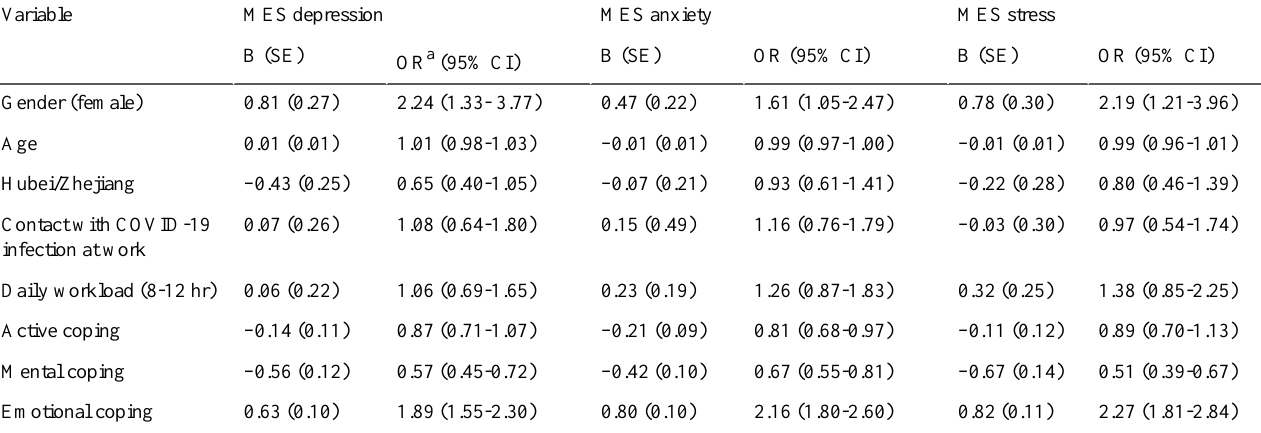
Table 5. Results of a logistic regression predicting the probability of experiencing moderate–extremely severe (MES) depression, anxiety, or